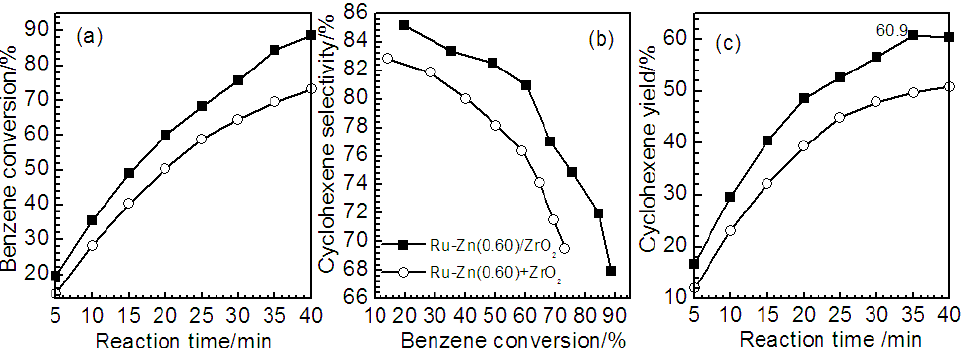
Figure 13. Catalytic activity towards selective hydrogenation of benzene over unsupported Ru-Zn (0.60) as well as Ru-Zn(0.60)/m-ZrO 2 (m(Ru-Zn (0.60)/m-ZrO 2 ) = 1.2 g, or m(Ru-Zn (0.60)) = 0.2 g and m(ZrO 2 ) = 1.0 g; m ZnSO4 = 50.0 g; v H2O = 280 cm 3 ; v benzene = 140 cm 3 ; T = 423 K; p H2 = 5.0 MPa). ( a ) Benzene conversion as function of reaction time; ( b ) Cyclohexene selectivity as function of benzene conversion; ( c ) Cyclohexene yield as function of reaction time.